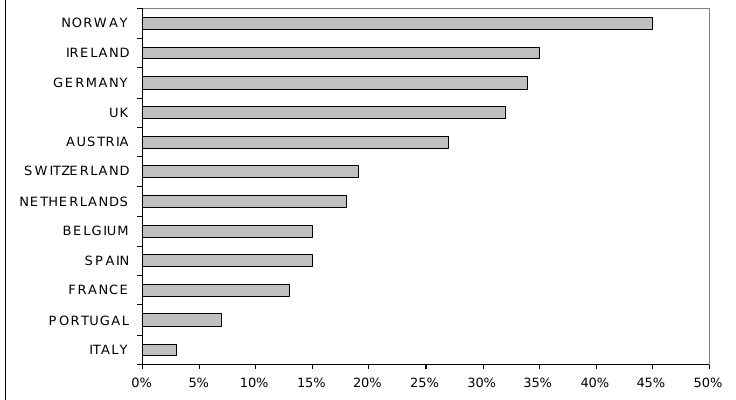
Figure 9: Non-Oil Revenues over Total Revenues –